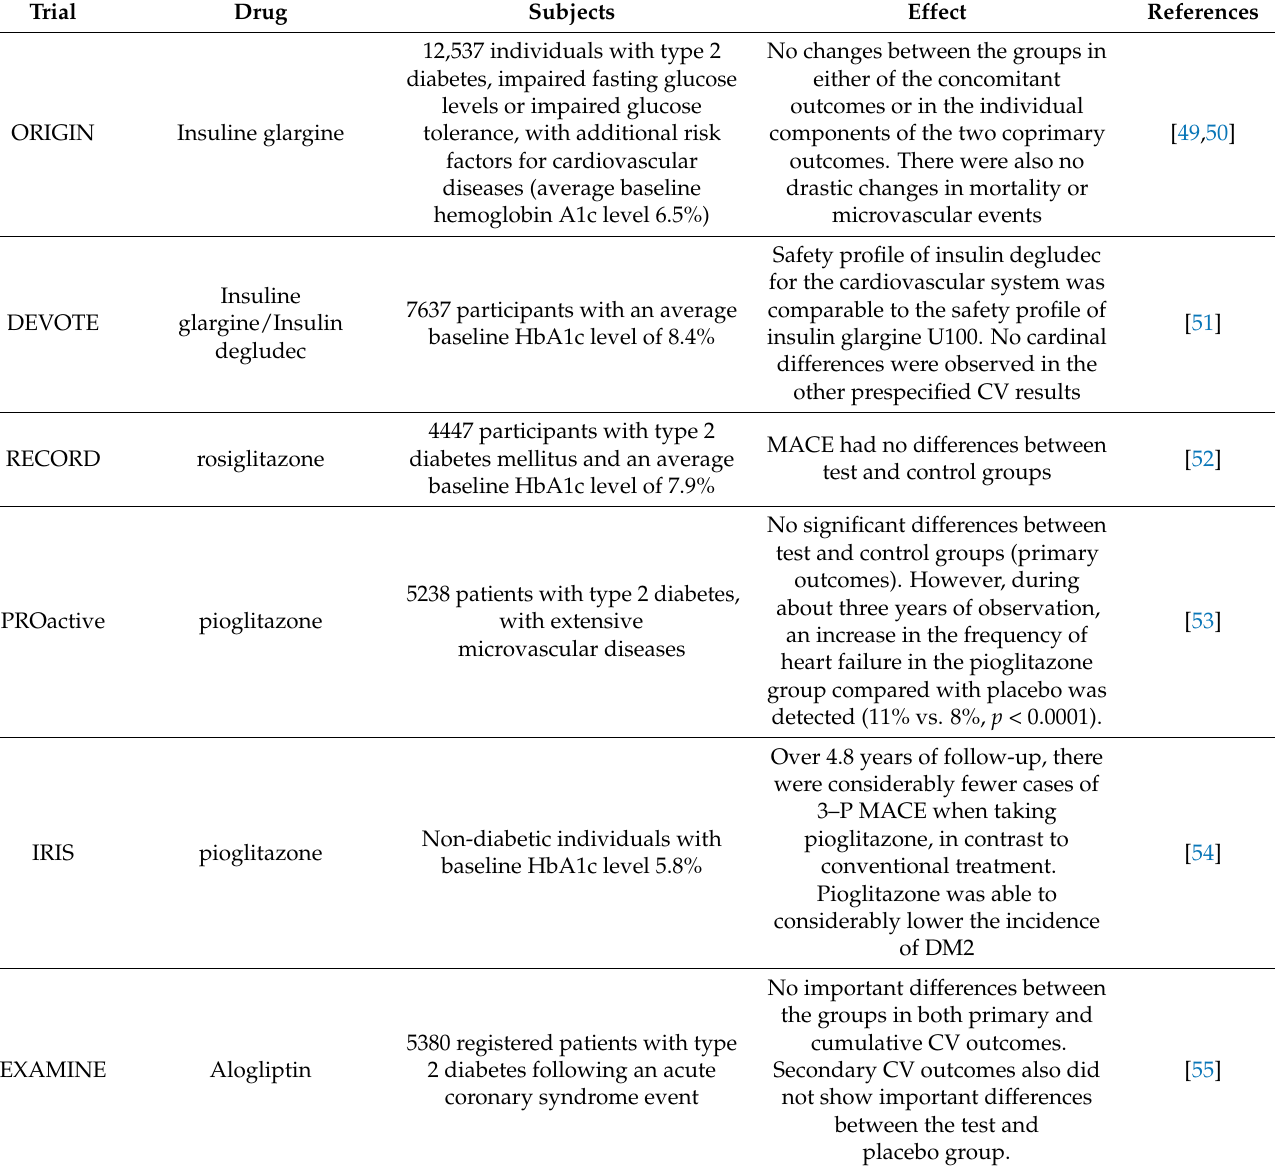
Table 1. CVOTs and their